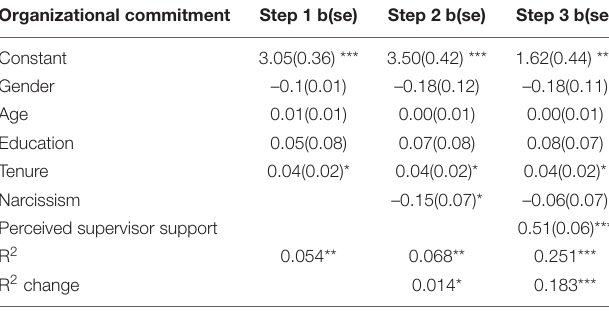
TABLE 3 | Results of hierarchical regression analyses.